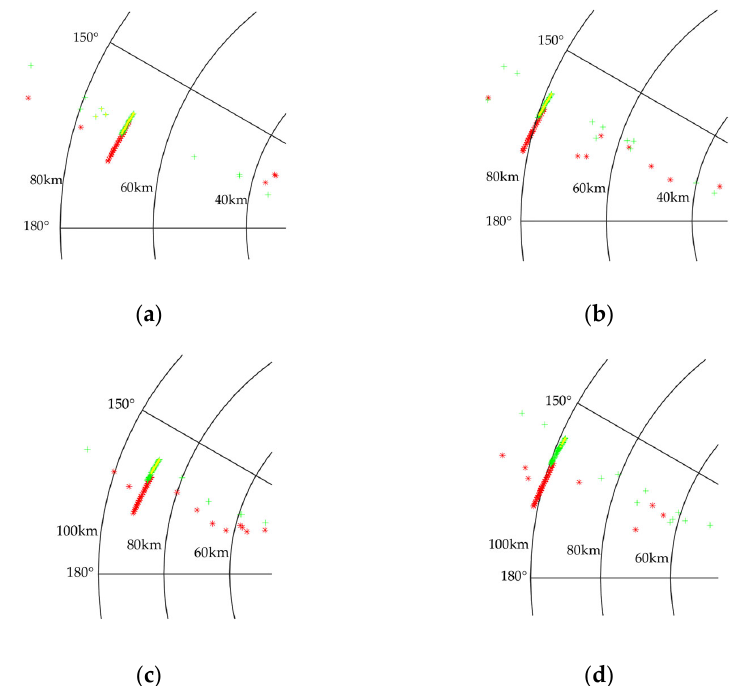
Figure 10. Fusion performance analysis in a two-radar system: ( a ) Target track fusion results when the jamming range delay is set as 10 km; ( b ) target track fusion results when the jamming range delay is set as 20 km; ( c ) jamming range delay is 30 km; ( d ) jamming range delay is 40 km (green line (plus) is detected by radar 1, red line (asterisked) is detected by radar 3, yellow line (dotted) is track that satisfies fusion criterion).